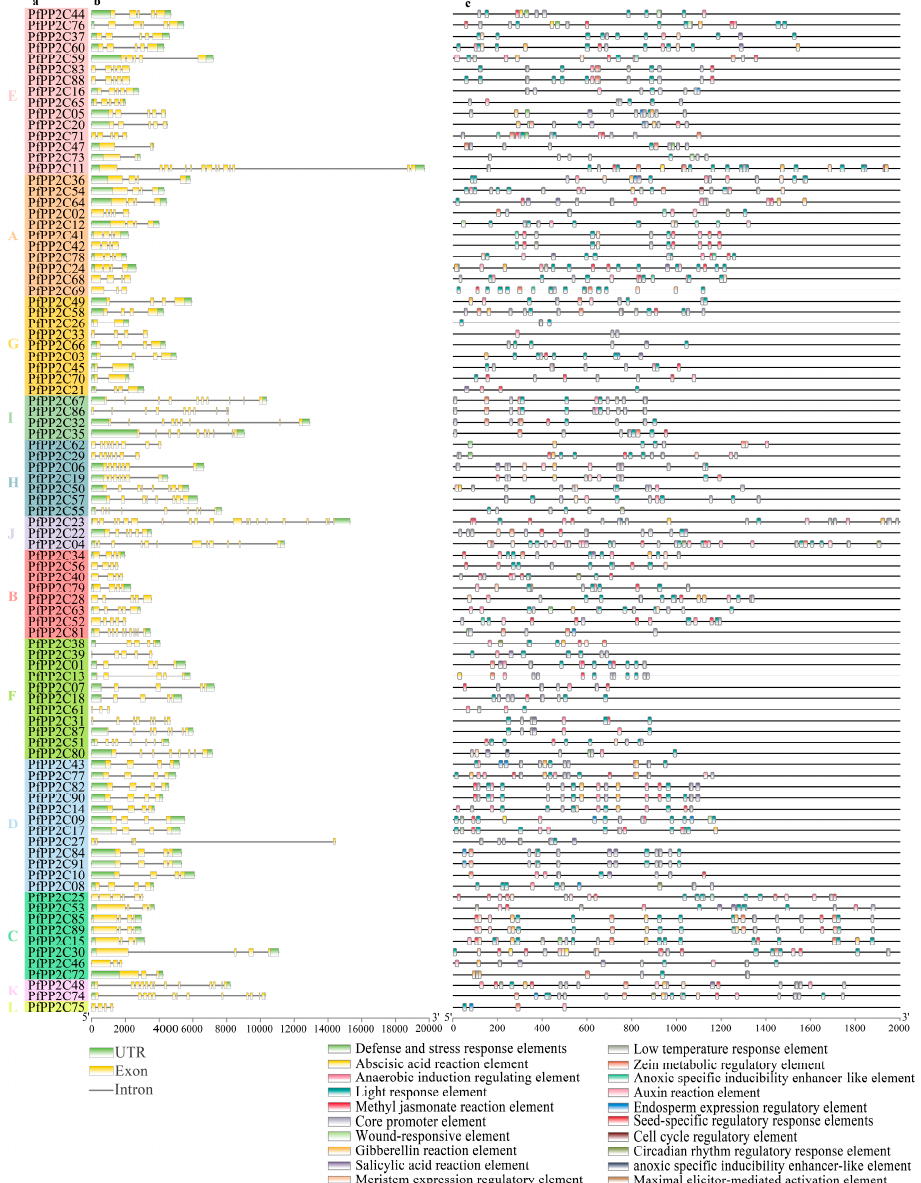
Figure 5. Analysis of the gene structure ( b ) and cis -element ( c ) of the PP2C g ene family in P. for- Figure 5. Subfamily grouping ( a ), analysis of the gene structure ( b ) and cis -element ( c ) of the PP2C tunei. gene family in P. fortunei